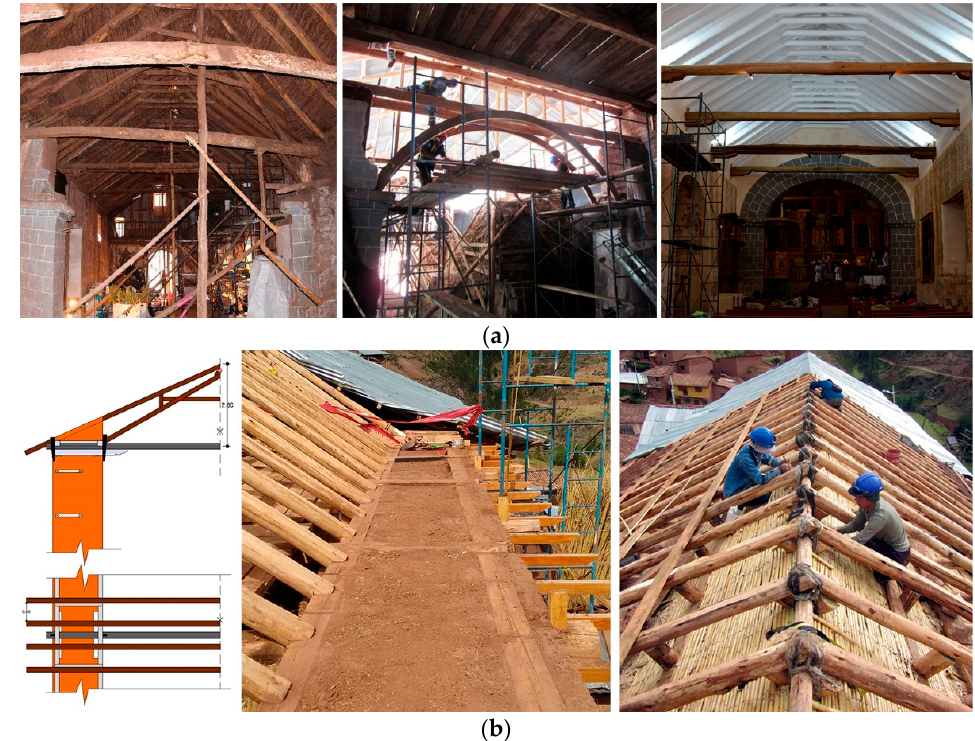
Figure 3. ( a ) Reconstruction of quincha arch; ( b ) Double rafter roof configuration. Note the anchor keys of the tie beam system, in the exterior and interior wall surfaces, highlighted in black. The roof structure was deemed inadequate in terms of local connections and